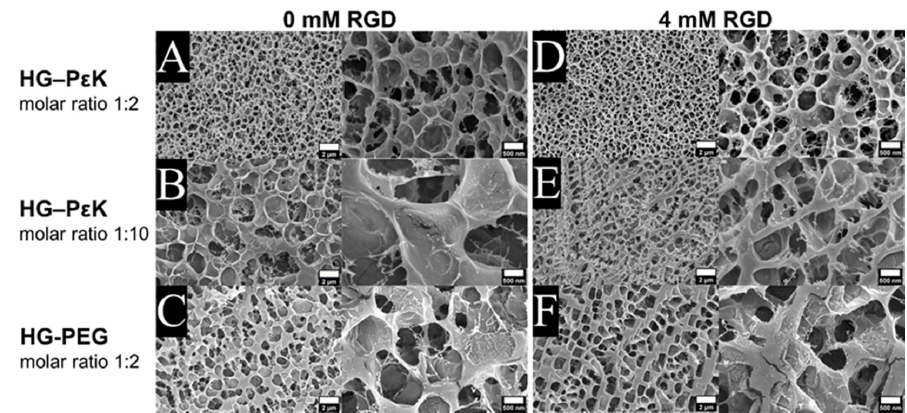
Figure 3. Hydrogel internal structures imaged by cryo-SEM. ( Left ) Hydrogel morphology without the RGD peptide for ( A ) HG-P ε K molar ratio 1:2, ( B ) HG-P ε K molar ratio 1:10, and ( C ) HG-PEG molar ratio 1:2. ( Right ) Hydrogel morphology with 4 mM RGD peptide for ( D ) HG-P ε K molar ratio 1:2, ( E ) HG-P ε K molar ratio 1:10, and ( F ) HG-PEG molar ratio 1:2. For each panel the scale bars in the left micrographs are 2 µm and right micrographs are 500 nm.